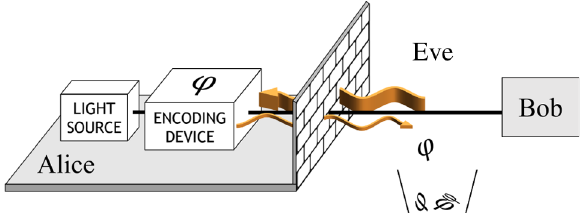
FIG. 1. Representation of the Trojan-horse attack against an optical QKD setup. Eve sends a large amount of Trojan photons (thick arrow) against Alice ’ s defensive structure. Some of the photons reach the encoding device, are encoded with the private information φ , and are reflected back to Eve (thin arrow), who retrieves the information by measuring the